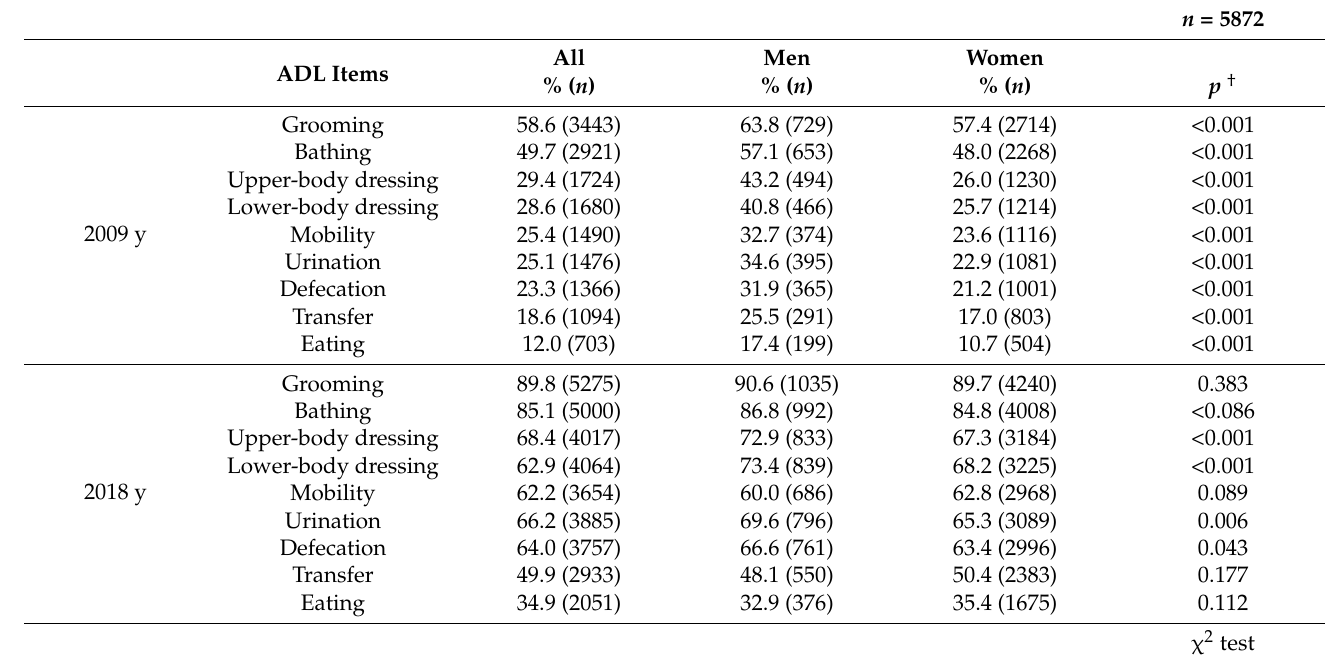
Table 2. Non-independency prevalence rates for ADL items in 2009 and 2018.